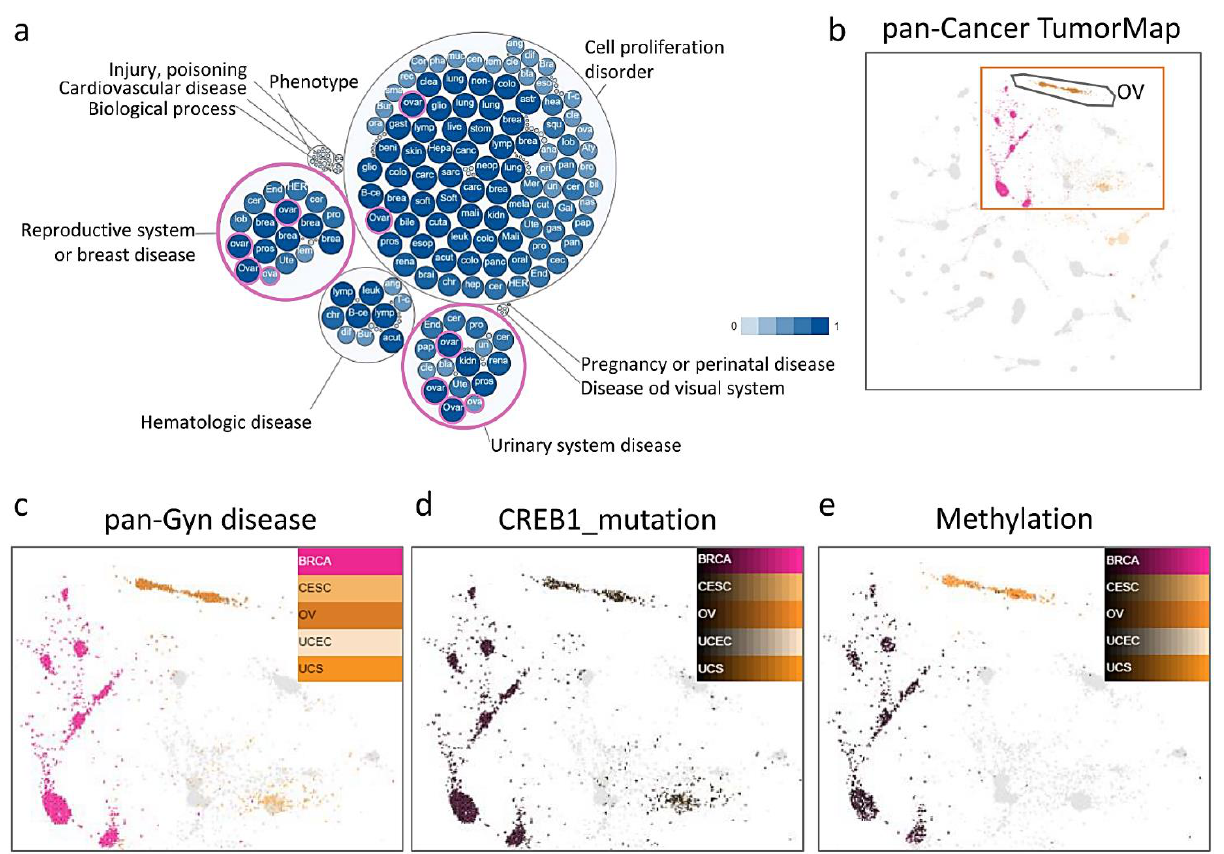
Figure 1. TumorMap and integrated cluster of gynecologic cancers from PanCancer-33 Analysis. ( a ) The distribution of CREB1 in various cancers and physiological functions. ( b ) TumorMap analysis visualizing close mapping of BRCA, CESC, OV, UCEC, and UCS among 28 PanCancer-33 islands. ( c ) Higher resolution view of TumorMap islands and distribution of Gyn cancers from five sites. ( d ) CREB1 mutation status showing the majority of mutation BRCA and OV map around a distinct island. ( e ) Methylation of Gyn cancers. Each spot in the map represents a sample. The colors of the sample spots represent attributes as described for each panel. BRCA: Breast invasive carcinoma, CESC: cervical squamous cell carcinoma and endocervical adenocarcinoma, OV: ovarian serous cystadenocarcinoma, UCEC: uterine corpus endometrial carcinoma, UCS: uterine carcinosarcoma.